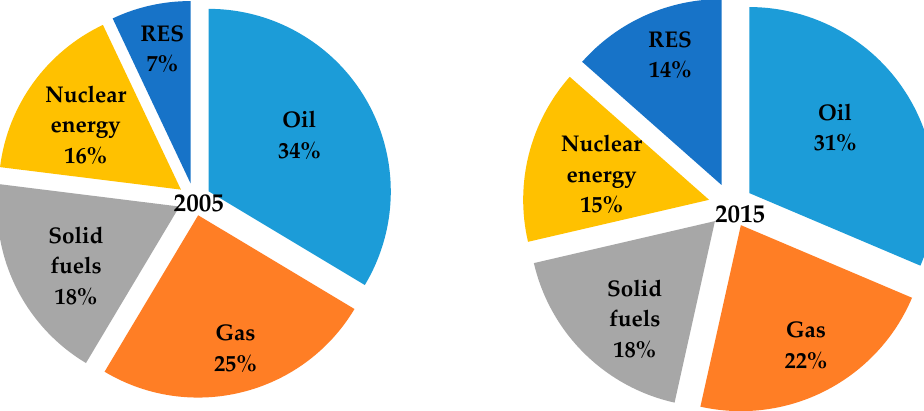
Figure 1. Primary energy consumption mix in EU28 in 2005 and 2015. Source: calculated from [20].